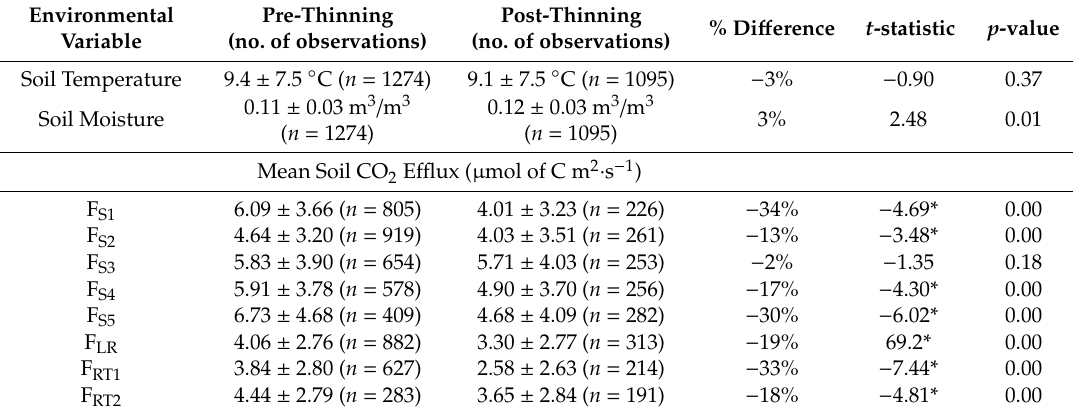
Table 1. Mean soil temperature, mean soil moisture and soil CO 2 e ffl ux, from total soil CO 2 e ffl ux (F S1 , F S2 , F S3 , F S4 andF S5 ), heterotrophicrespiration(F RT1 andF RT2 )andmineral-soilhorizonrespiration(F LR